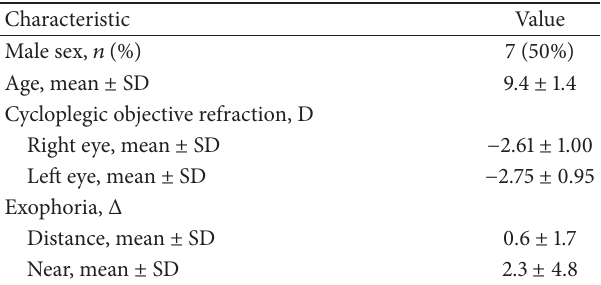
Table 1: Baseline